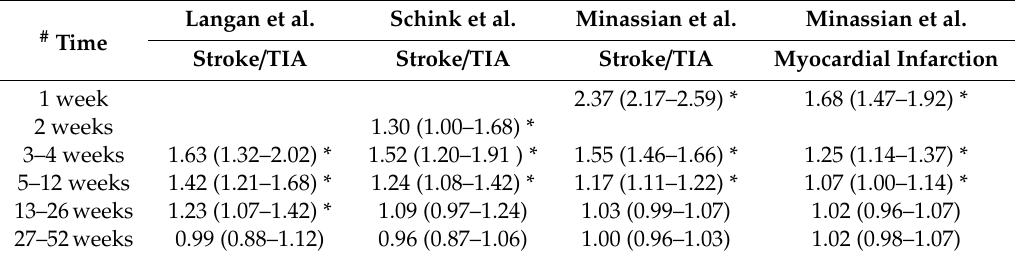
Table 5. Age ‐ adjusted incidence ratios for stroke/TIA or myocardial infarction in length of follow ‐ up Table 5. Age-adjusted incidence ratios for stroke / TIA or myocardial infarction in length of follow-up time after herpes zoster in three different self ‐ controlled case series studies. time after herpes zoster in three di ff erent self-controlled case series studies.